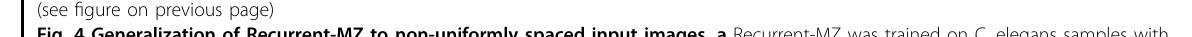
the performance consistency over the inference axial range: by decreasing Δ z , Recurrent-MZ demonstrates a better peak inference performance, indicating that more accurate propagation has been learned from smaller Δ z , whereas the variance of PSNR, corresponding to the performance consistency over a larger axial range, is degraded for smaller Δ z .